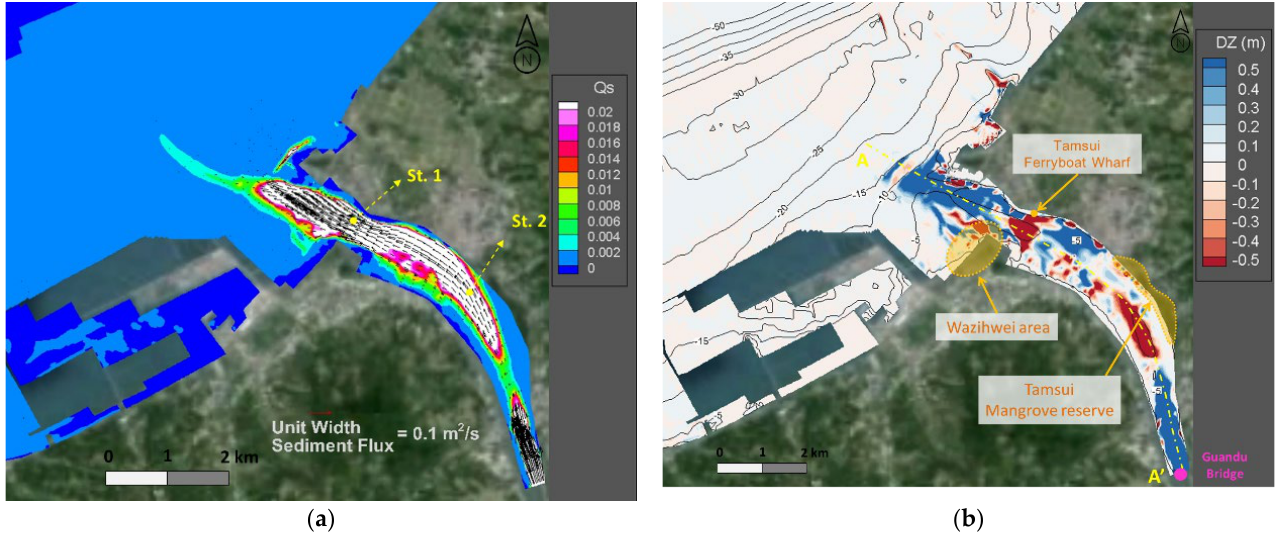
Figure 6. Sediment flux distribution and changes in bed scouring and deposition of Case 1 (DZ = bed change, the contour line is bed elevation. The unit is meters for both). ( a ) Distribution diagram of sediment flux at peak time. ( b ) Simulation results of bed scouring and deposition.